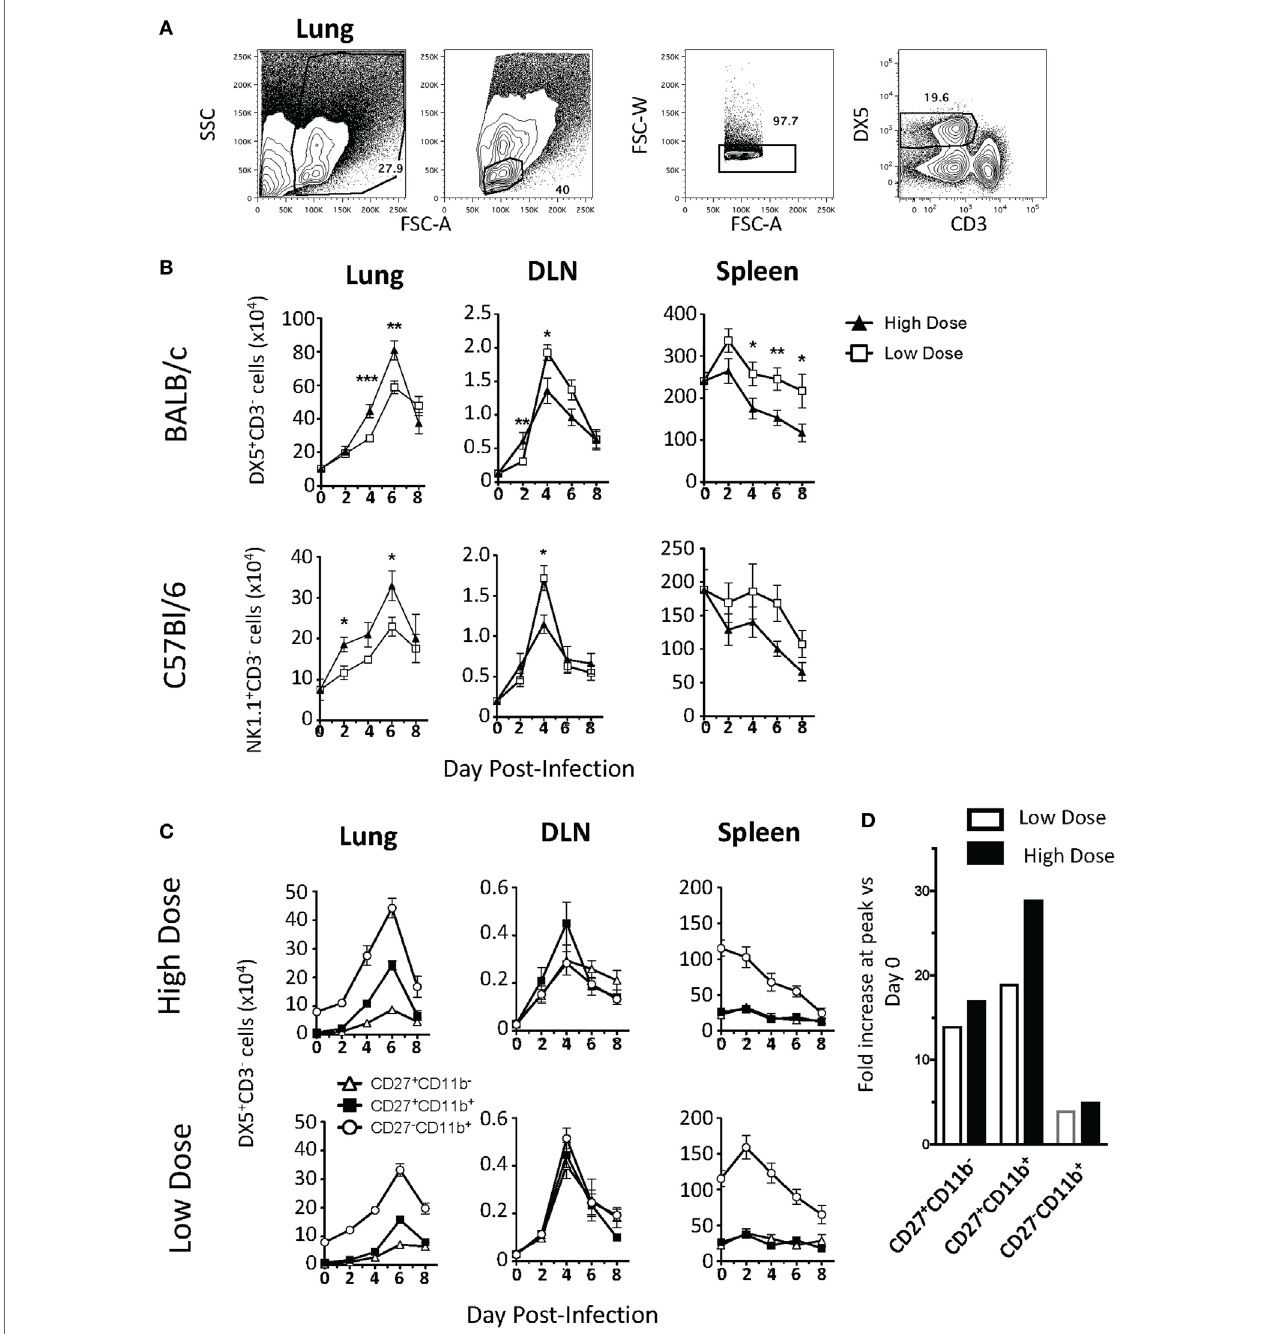
FigUre 1 | Kinetics of natural killer (NK) cell accumulation during high- and low-dose influenza A virus (IAV) infections. (a) Representative gating strategy for DX5 + CD3 − NK cells in the lungs. (B) BALB/c (top) or C57Bl/6 (bottom) mice were infected with a high (1 LD 50 ) or low (0.1 LD 50 ) dose of A/PR/8/34. NK cells were enumerated in the lung, lung-draining lymph node (DLN), or spleen at the indicated time points by flow cytometry. Shown are DX5 + or NK1.1 + CD3 ε − cells. The number of NK cells in the DLN is expressed as NK cells per node. (c) NK cells (DX5 + CD3 ε − gated) within the lung, DLN, and spleen in BALB/c mice were further characterized by CD27 and CD11b expression to determine the distribution of functional subsets during both high- (top) and low (bottom)-dose IAV infections. Shown are p -values for high- vs. low-dose IAV infections. * p < 0.05, ** p < 0.005, *** p < 0.001 (two-tailed unpaired Student’s t -test). The number of NK cells within the lung of high- and low-dose IAV-infected mice was found to be significantly greater than the number of NK cells in naïve lungs at days 2, 4, and 6 p.i. ( p < 0.05). The decrease in NK cell numbers in the spleen was found to be significantly greater in high-dose-infected mice by two-way ANOVA ( p < 0.001). Data are pooled from at least two separate experiments, with five mice per time point, per experiment. (D) The fold increase in CD27 + CD11b − , CD27 + CD11b + , and CD27 − CD11b + NK cells within the lungs was calculated by dividing the cell number found with the lungs at the peak of the response by the cell number found within the lungs at day 0.